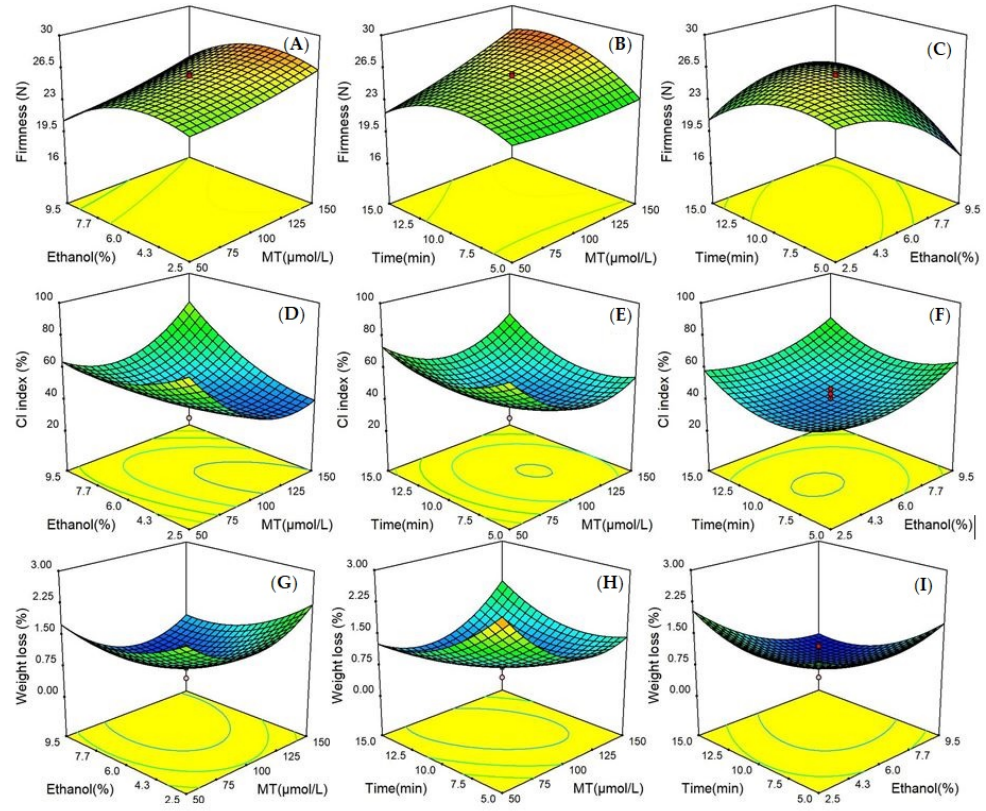
Figure 1. Response surface plots showed effects of treatment variables on firmness, CI index, and weight loss: ( A , D , G ) at varying MT and ethanol concentration; ( B , E , H ) at varying MT concentration and immersion time; ( C , F , I ) at varying ethanol concentration and immersion time.